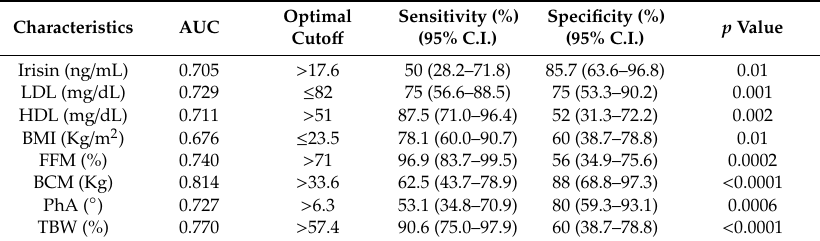
Table 4. Accuracy of irisin, lipid profile measures, anthropometric and body composition parameters as predictors of the intensity level of physical activity.